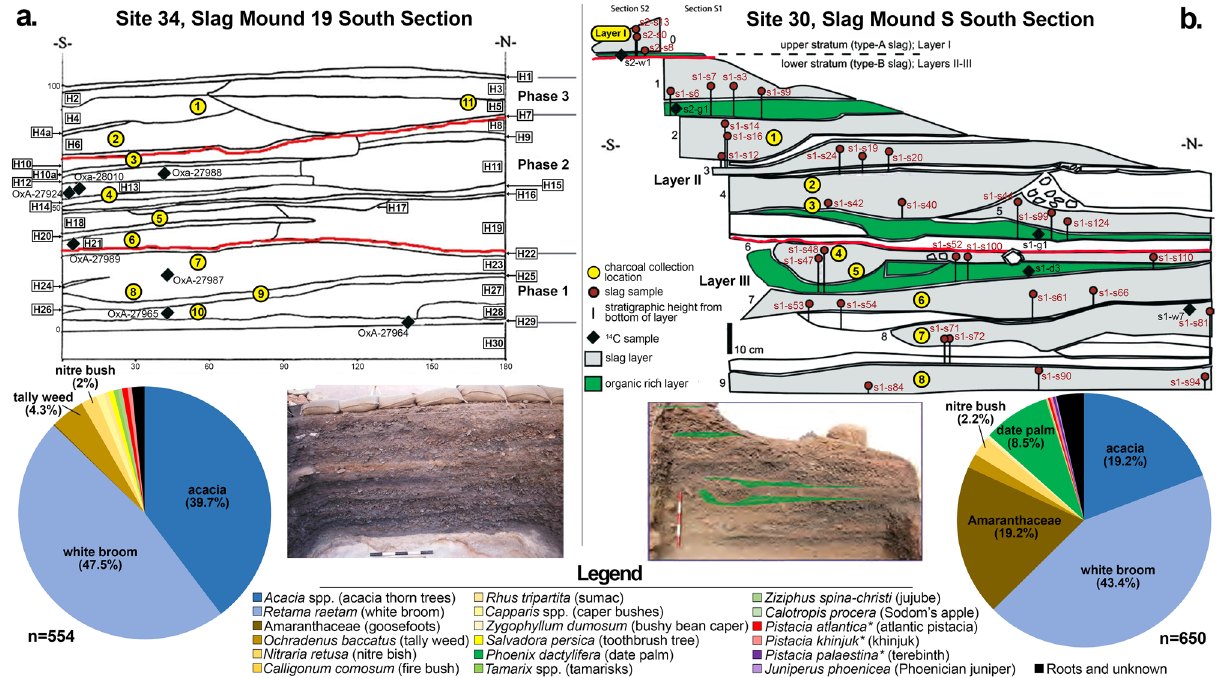
Figure 3. Images and section drawings of sampled slag mounds, ( a ) Slag Mound 19 at Site 34 and ( b ) Slag Mound S at Site 30. Probe locations (yellow circles) as well as radiocarbon sample locations (black diamonds) are indicated with assigned Field IDs. Absolute percentages of identified charcoal from each slag mound are given in pie charts. See Supplementary Tables 1 and 2 for results of radiometric analyses relevant to the dating of both slag mounds. Legend entries with asterisks indicate